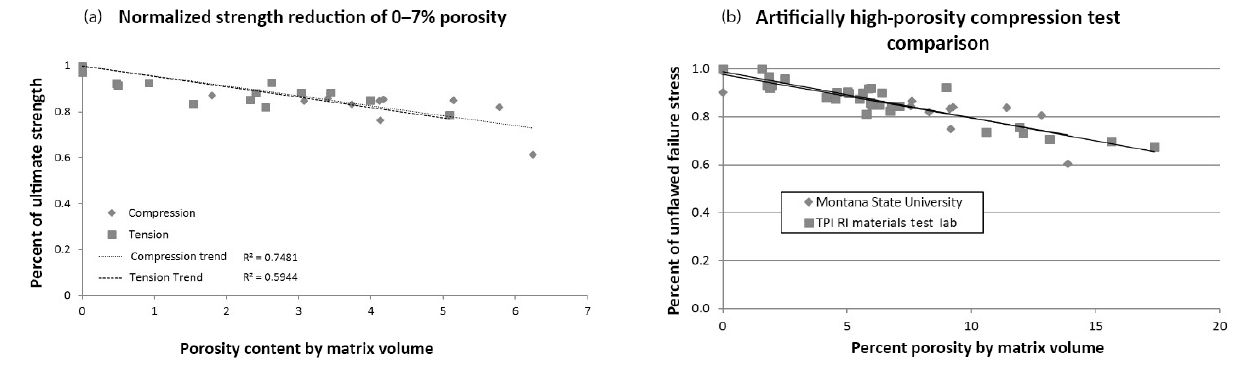
Figure 10. Reduction in strength due to porosity in the 0 to 7% porosity range and comparison with the high-porosity blade manufacturer data set (b)